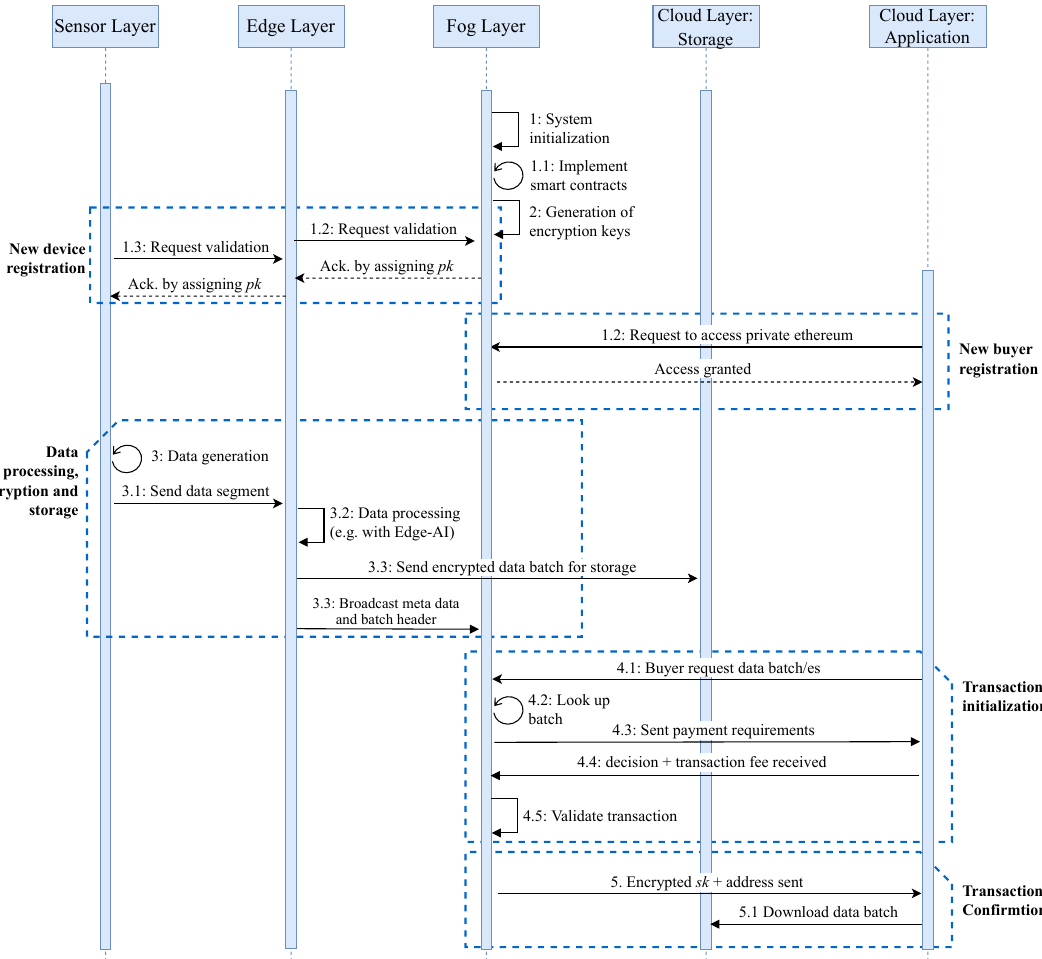
Figure 2. System sequence diagram depicting sequential picture of complete